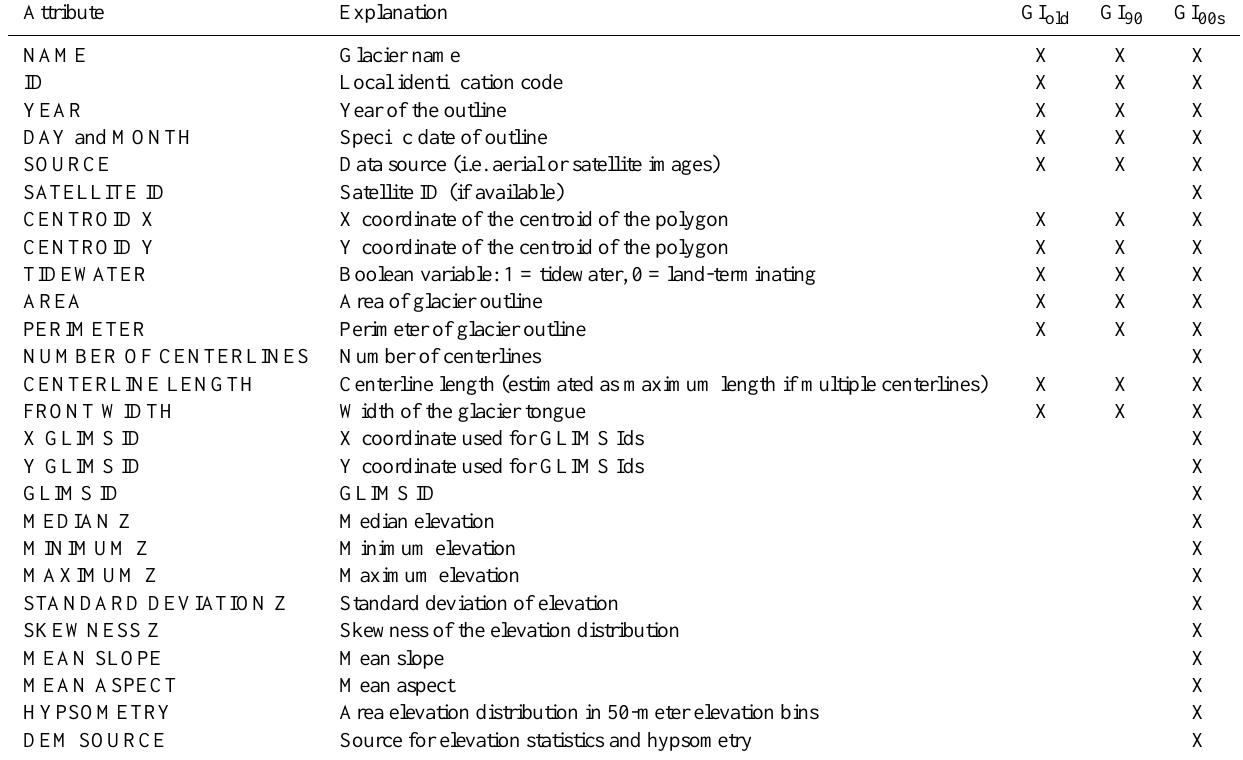
Table 3. List and description of attributes available for each glacier inventory.